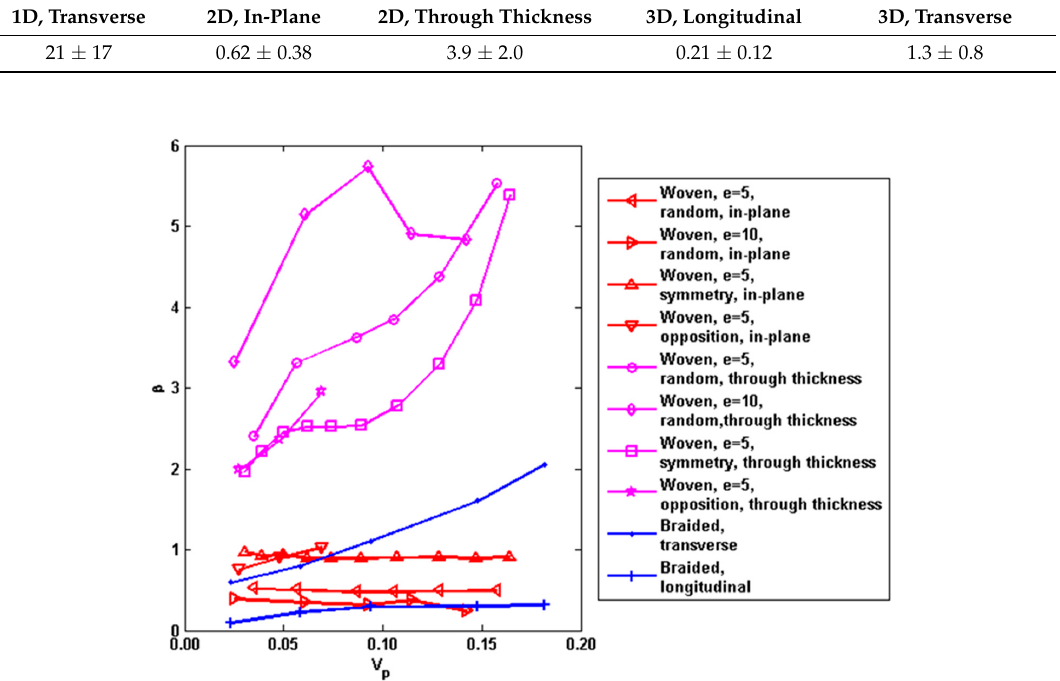
Figure 9. The calculated values of β with macro-porosity for different macro-pore structures.